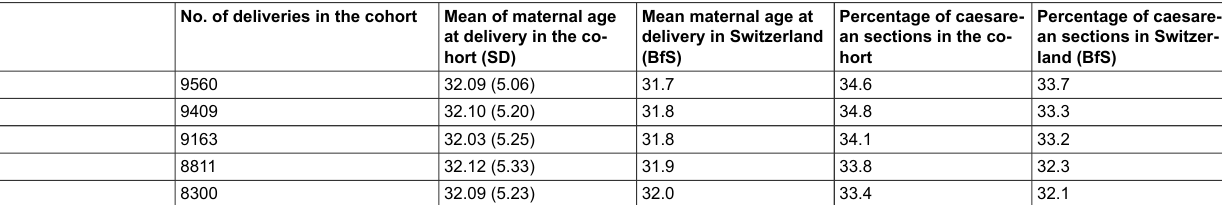
Table S1: Description of the study population (crude numbers).